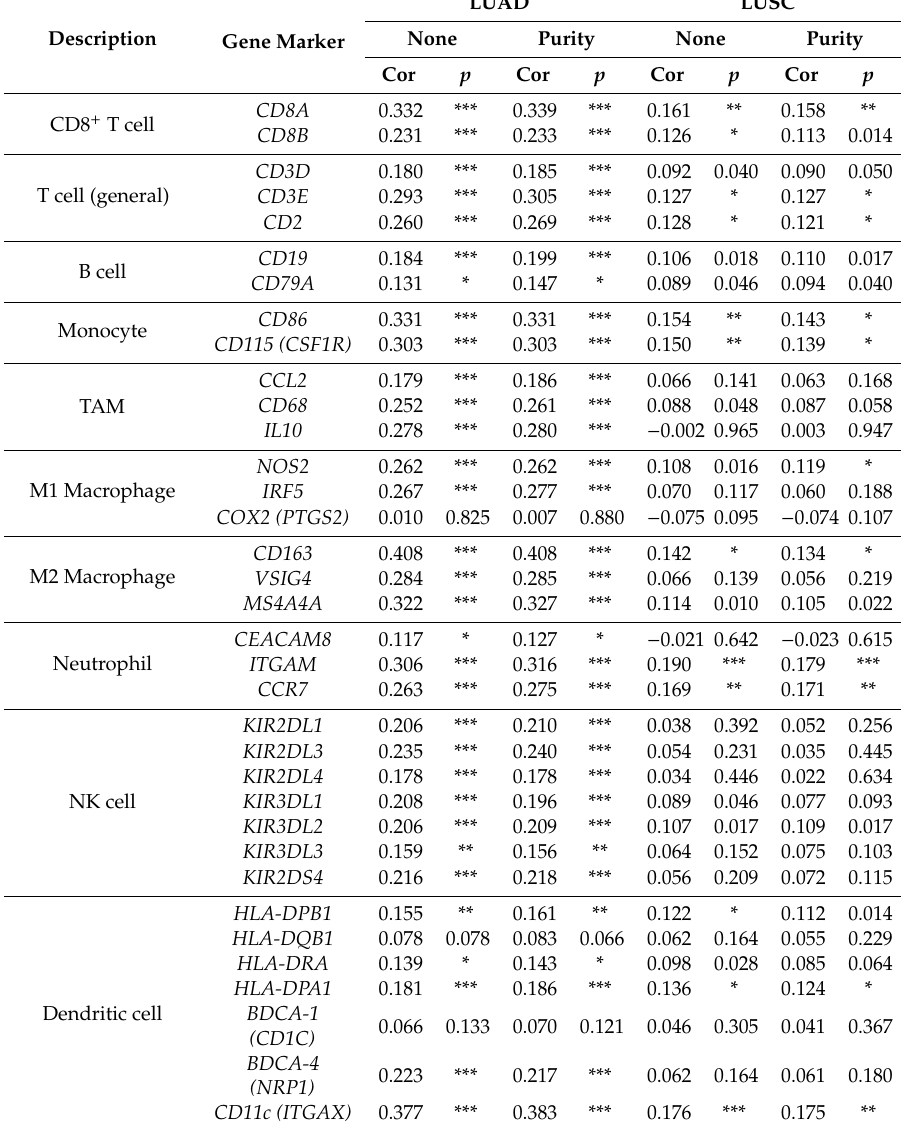
Table 2. Analysis of correlation between ATP / GTP binding protein 1 ( AGTPBP1 ) and immune cell gene markers using tumor immune estimation resource (TIMER)